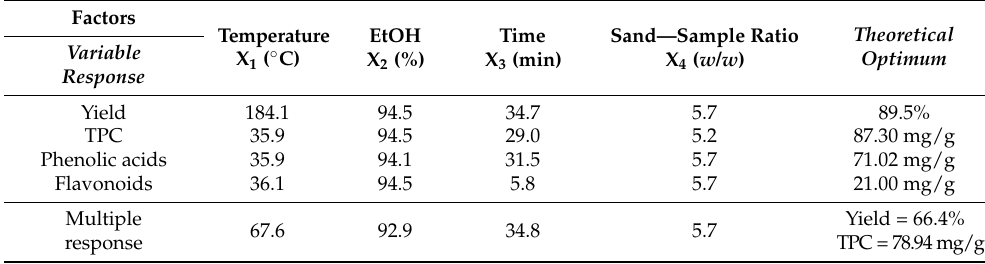
Table 4. Theoretical values of independent variables to maximize the response variables provided by the